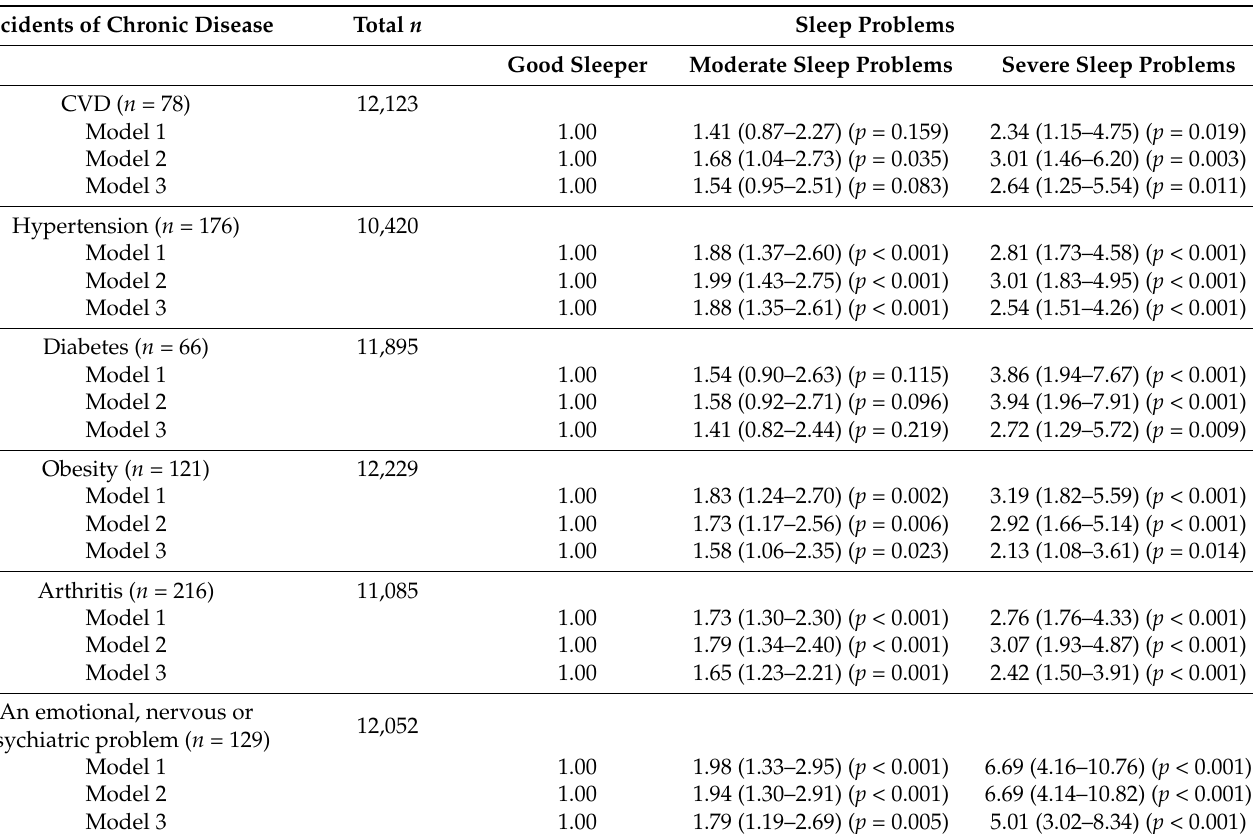
Table 2. Odds ratios (95% Confidence Intervals and p Values) for incidents of chronic disease according to the level of sleep problems over 15 months during the COVID-19